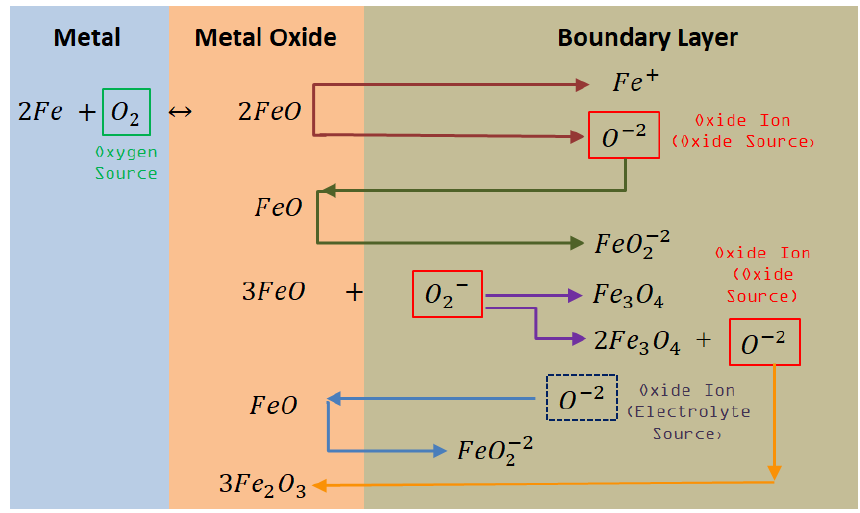
Figure 3. Corrosion mechanisms of Fe in contact with Oxyanionic Salts.